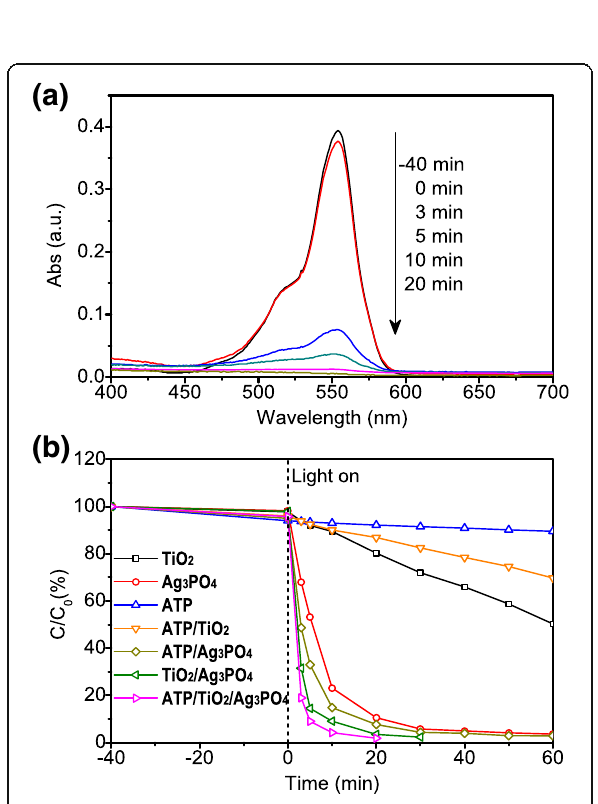
Fig. 4 a UV-vis absorption spectra of the photocatalytic degraded RhB solutions by the ATP/TiO 2 /Ag 3 PO 4 ternary nanocomposite at different times. b Photocatalytic degradation of RhB with different photocatalysts under simulated solar